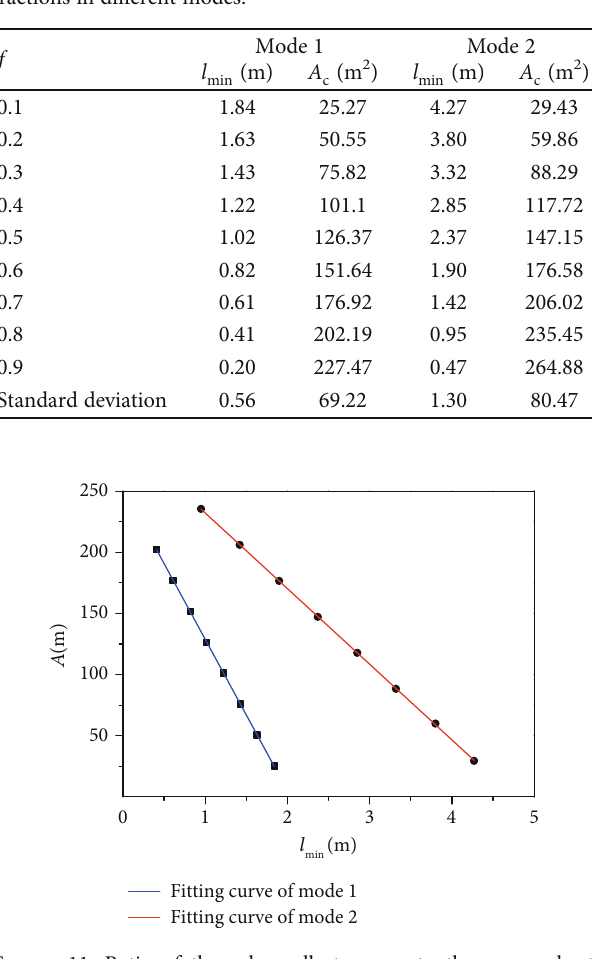
Figure 12: (a) Ratio of the solar collector area to the sewage heat exchanger minimum length with respect to the solar fraction. (b) Ratio of solar collector area to the thermal storage volume with respect to the solar fraction.